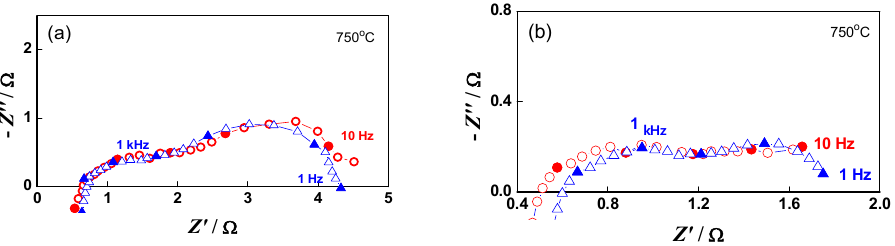
Figure 13. Impedance diagrams of button cell after the initial reduction ( ∆ ) and after the 6th redox cycle ( ○ ): ( a ) at OCV; ( b ) under load 0.10 A.cm −2.